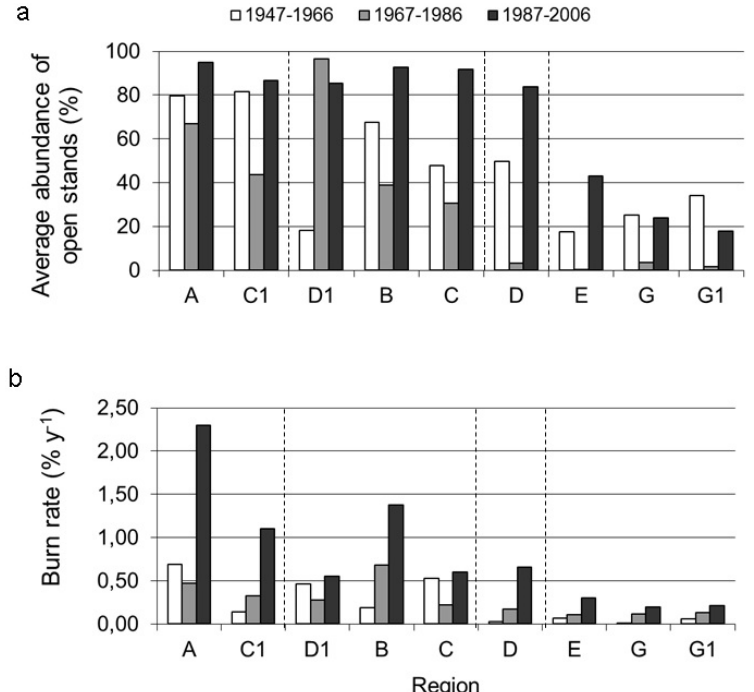
Figure 4. Average abundance of open stands by fire region for three 20-year periods (1947–1966, 1967–1986, and 1987–2006) ( a ); and corresponding regional burn rates by periods ( b ).